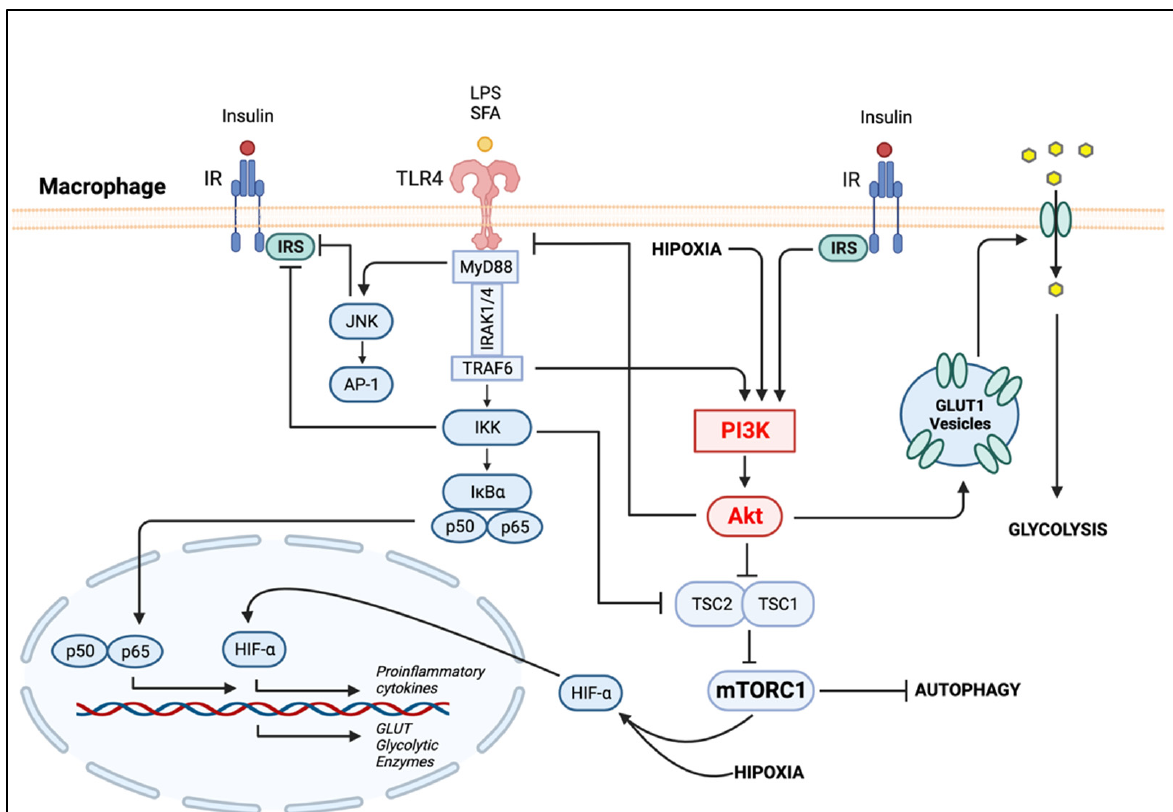
Figure 2. PI3K/Akt Signaling in Adipose Tissue Macrophages. Bacterial LPSs or SFAs stimulate